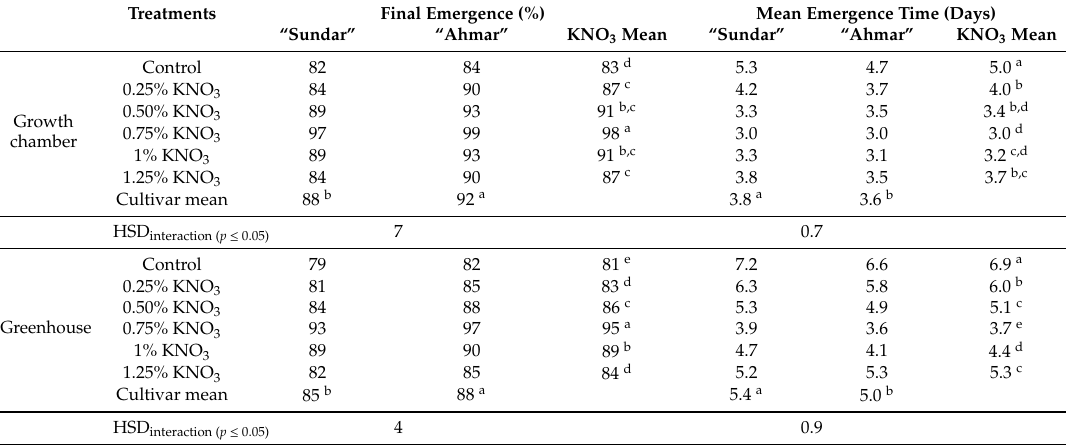
HSD interaction( p ≤ 0.05) Values sharing the same letters are non-significantly di ff erent ( p ≤ 0.05).